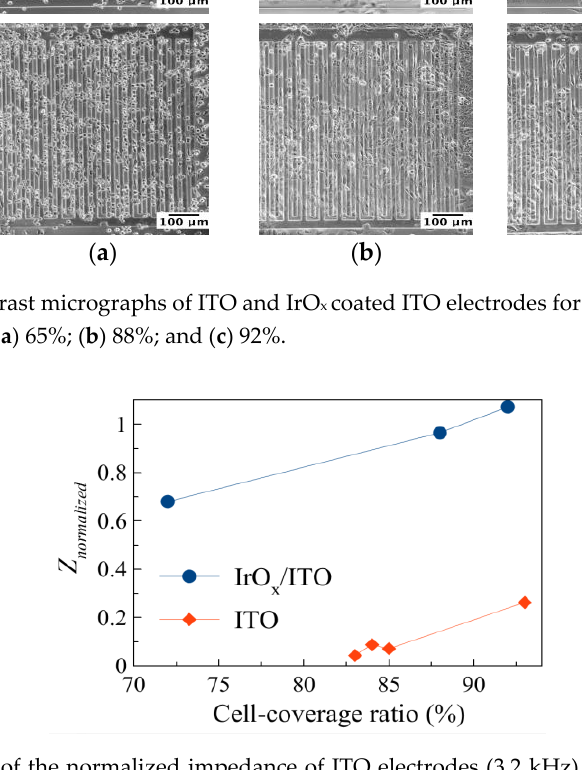
Figure 2. Evolution of the normalized impedance of ITO electrodes (3.2 kHz) and ITO coated with IrO x (8 Hz) as a function of cell coverage